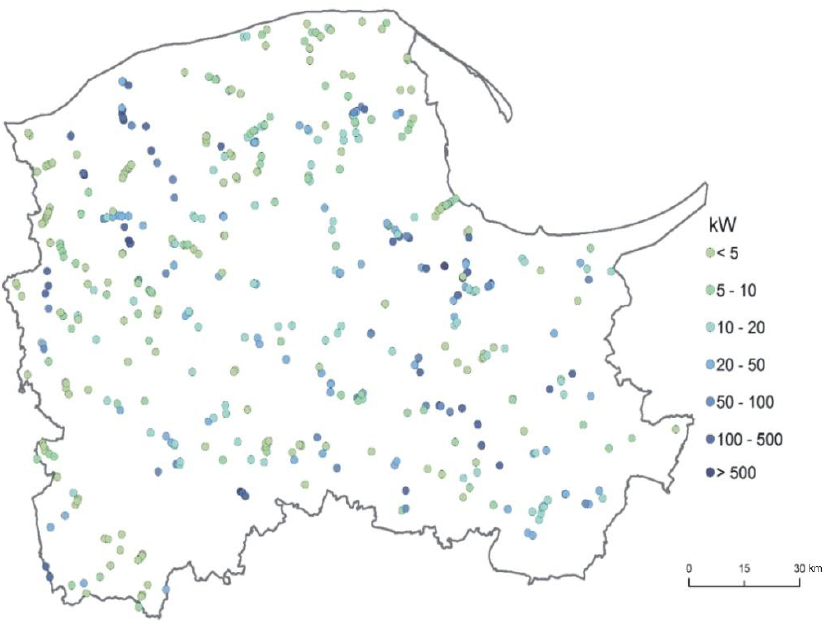
Figure 8. The location of the dams and the power of small hydroenergy plants that can be built in the Pomerania Voivodeship (own study from